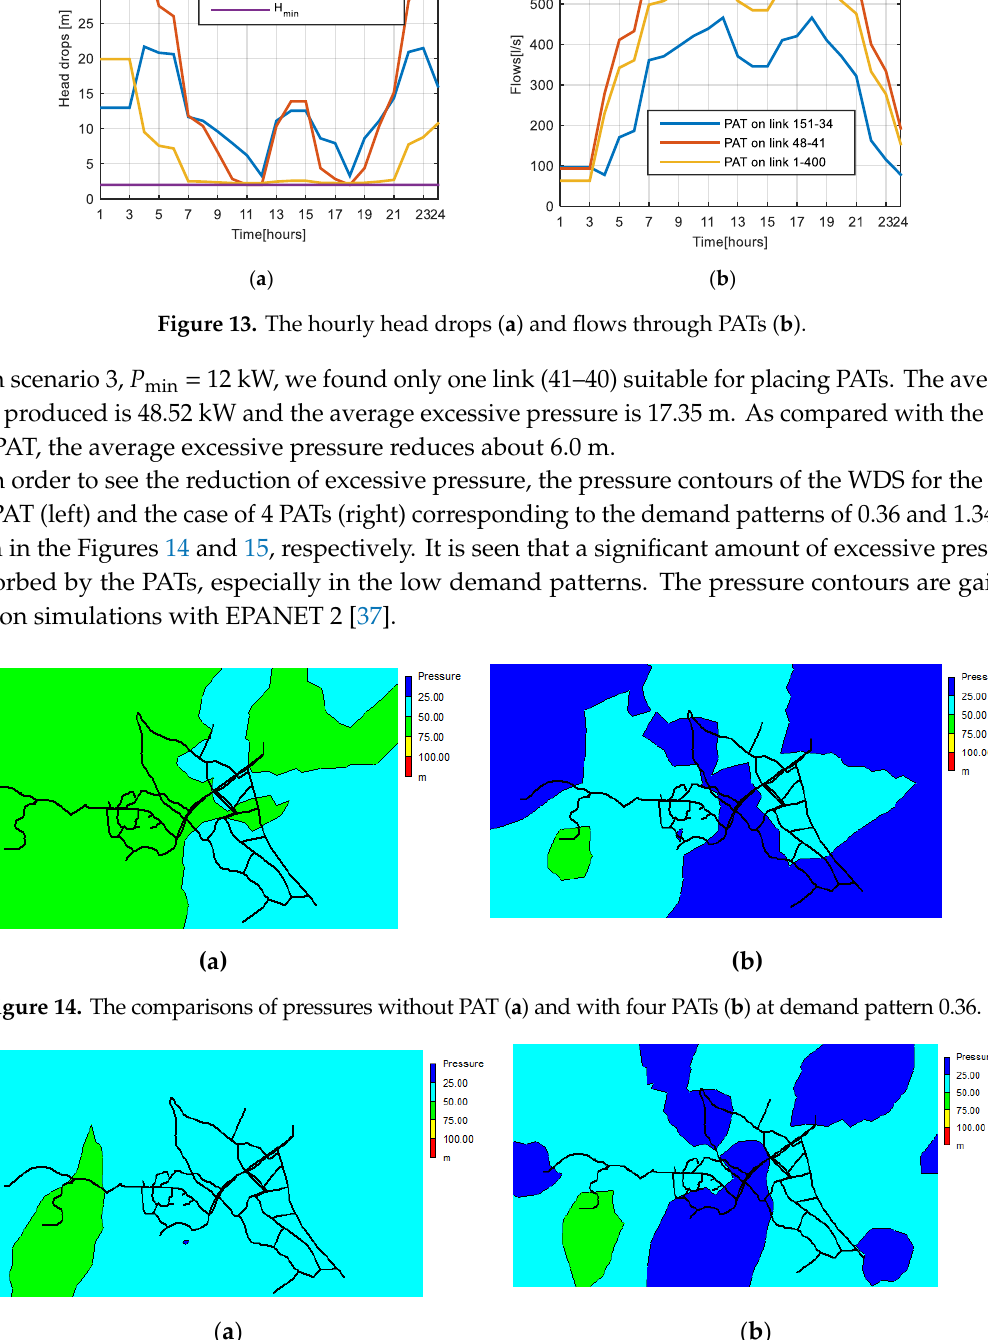
Figure 12. Profiles of hourly powers for three PATs.